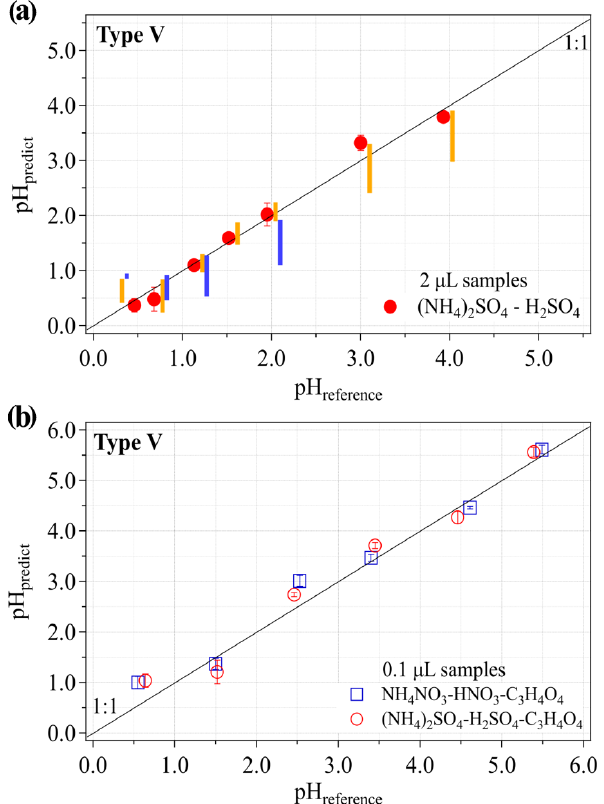
Figure 4. pH estimation using the type V pH paper for salt sys- tems with only inorganic acids (a) and both inorganic and organic acids (b) . pH predict is calculated with the averaged coefficient vector [ a , b , c ] derived from three replicate calibration experiments with standard buffers and under constant photographing conditions. The error bars represent the SD of three to four replicate experiments. The dotted line in (a) is used to guide the